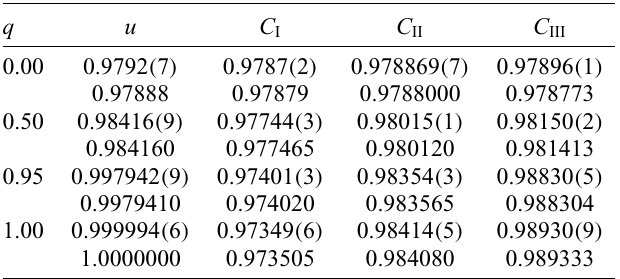
TABLE V. Fitting results for p = 0.01 in the two-qubit 2- RB. In each cell, fitting results are written in the first line and theoretical values are written in the second line.